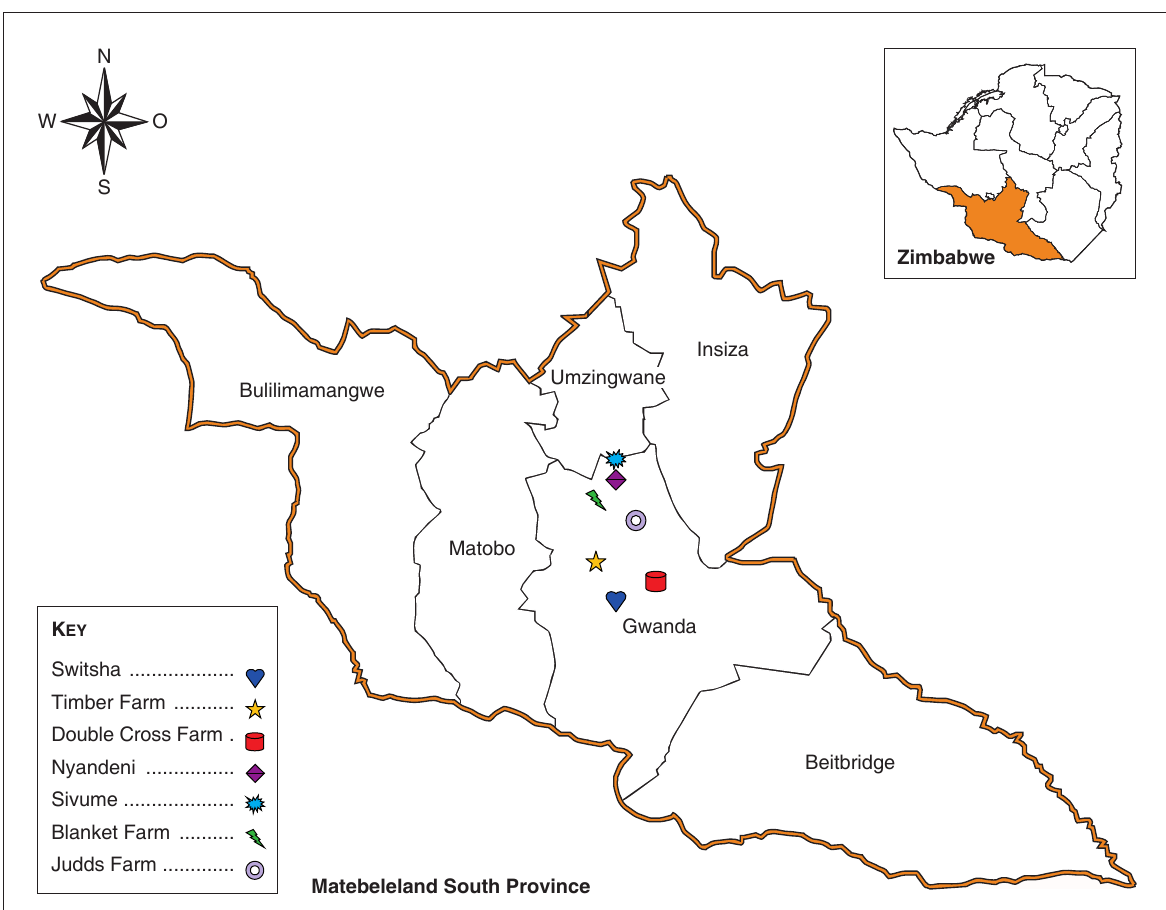
FIG. 1 Maps of Zimbabwe and Mattabeleland South Province showing study areas in Gwanda